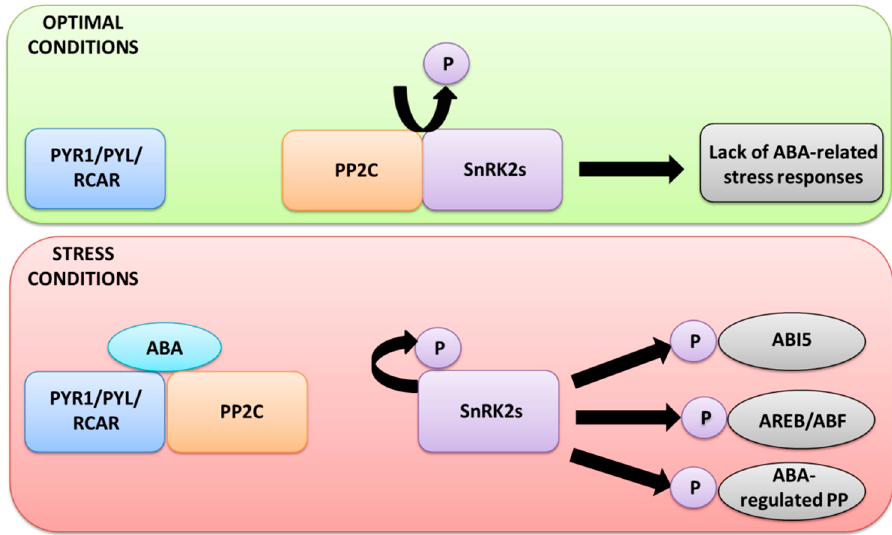
Figure 2. Changes in the ABA - receptor binding under optimal and stress conditions, and resulting alternations in ABA-dependent signal transduction pathways.PYR1/PYL/RCAR - protein receptors pyrabactin-resistance 1/pyrabactin resistance-like/regulatory component of ABA receptors; PP2C-protein phosphatase 2C; SnRK2-activates sucrose non-fermenting 1 (SNF1)-related protein kinases 2; ABI5-ABA INTENSIVE 5; AREB-ABA-responsive element (ABRE)-binding proteins; ABFs-ABRE-binding factors; PP-phosphoproteins.